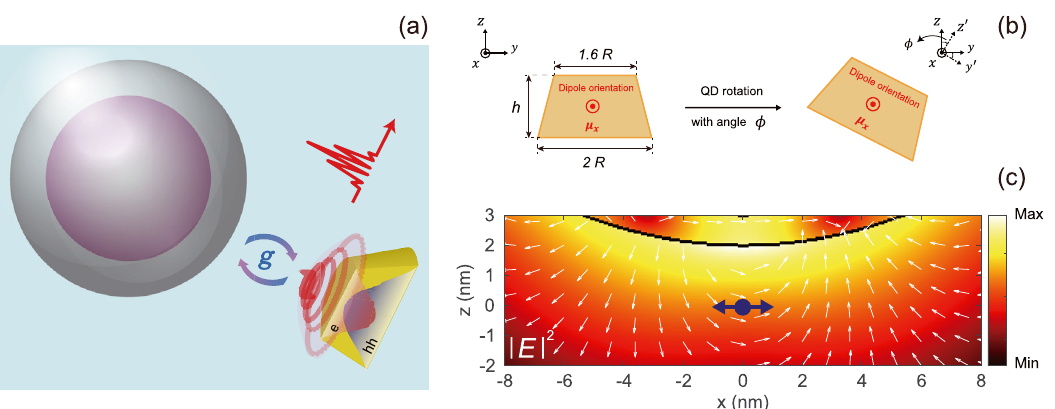
Figure 1: Physical models of the coupled plasmon-QD system and the QD. (a) Schematic diagram of an InA/GaA QD coupled to a silver nanoshell. The QD has spatially extended electron and hole wave functions. (b) QD rotation along the dipole orientation ( x axis). The cross section of QD is trapezoid, with height h and radius R . (c) Vector map and electric field intensity distribution for plasmonic field generated by an x -oriented dipole source (blue dot and arrow) located 2 nm from